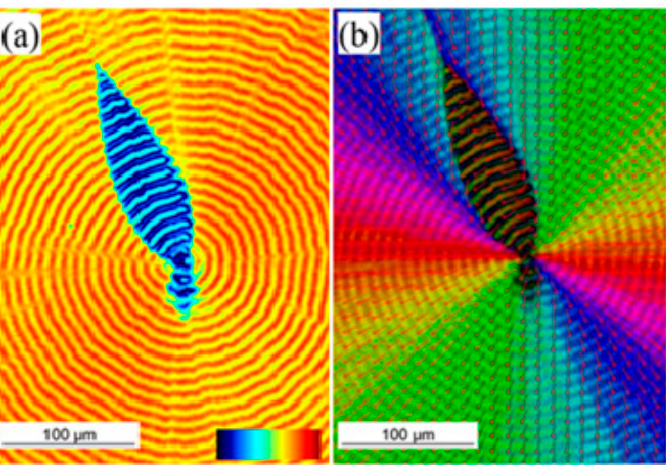
Figure 4. Polscope images of a poly( R -3-hydroxyvalerate) spherulite: ( a ) Magnitude of birefringent retardance, which is given as pseudo-color. Thicker film and larger crystal birefringence leads to higher retardation. Red corresponds to 273 nm retardance and black corresponds to zero birefringence. ( b ) Orientation of the slow optical axis (corresponding to the largest refractive index of the crystal in the film plane) in each location, which is typically shown by short lines for every 15 pixels in the horizontal and vertical direction of the original video frame. Reprinted with permission from Ref. [17]. Copyright (2009) American Chemical Society.